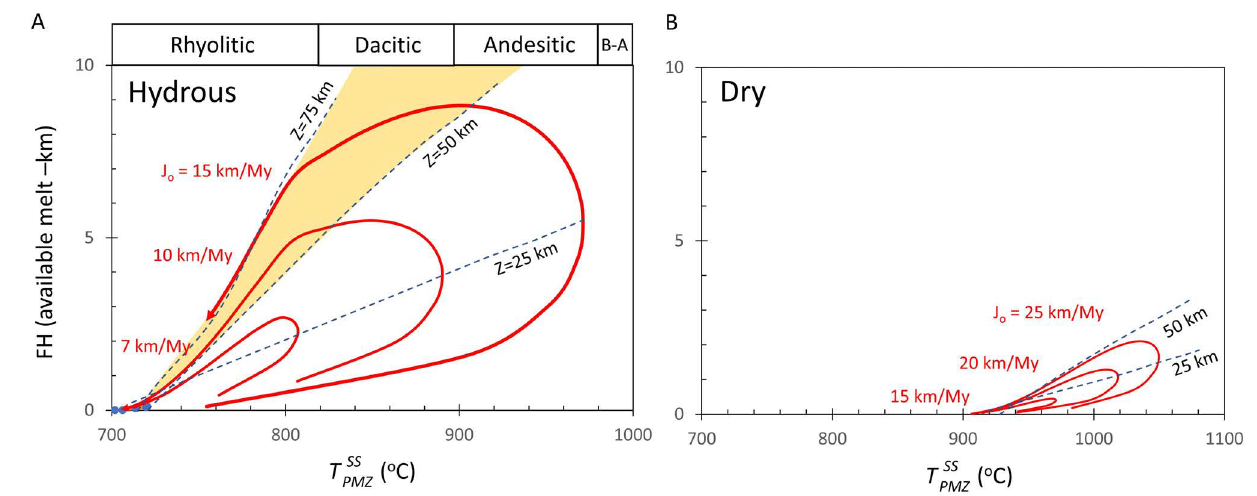
Figure 6: Total available melt ( FH ) that can be extracted from the PMZ and emplaced into the upper crust versus steady state temperature T SS of the PMZ. Top horizontal axis represents approximate composition of melt. PMZ Three scenarios are shown (red curves) for different baseline levels of magmatic recharge J o . Arrow shows the in direction of increasing crustal thickness. [A] is for a hydrous system with a wet solidus of 700 °C and liquidus of 1200 °C. [B] is for a dry system with a solidus of 900 °C and a 1200 °C liquidus. Dashed lines represent contours of crustal thickness. Basal heat flow of 15 mWm − 2 assumed for [A] and